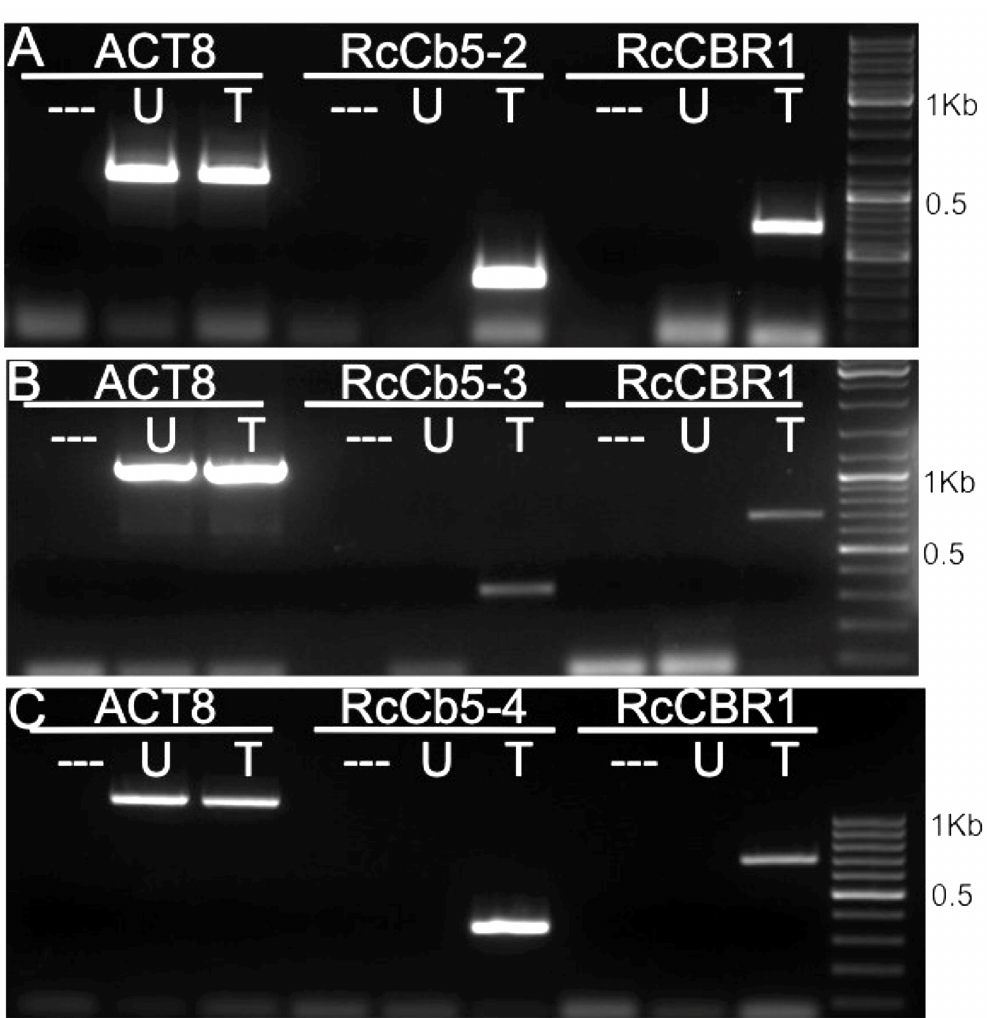
Figure 7. Reverse transcriptase-PCR from representative RcCBR1+RcCb5 CL37 T Rc CBR1 +Rc Cb5-3 #12 and ( C ) Rc CBR1+RcCb5-4 #20. RNA prepared from developing siliques was subject to RT-PCR using gene-specific primers. In each panel, --- indicates no-template control. U indicates untransformed CL37, T indicates homozygous transformant. The ACTIN8 gene ( ACT8 , At1g49240) was used as a control to test RNA quality.